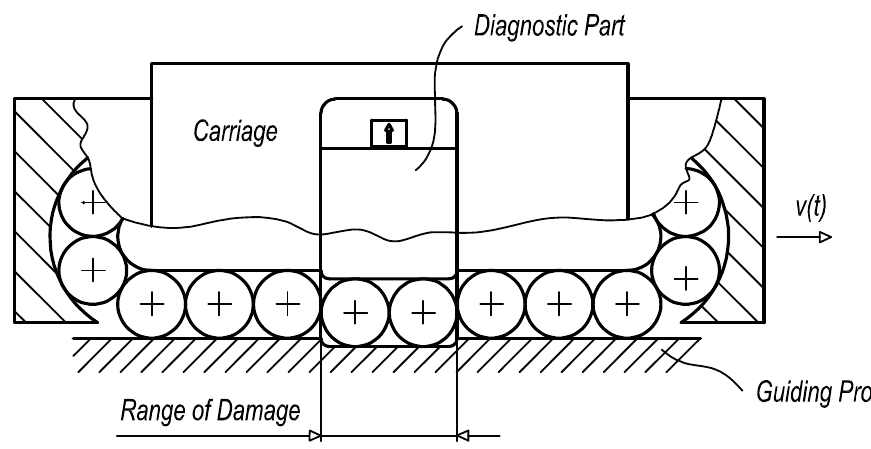
Figure 8. The limit range of guiding profile damage.